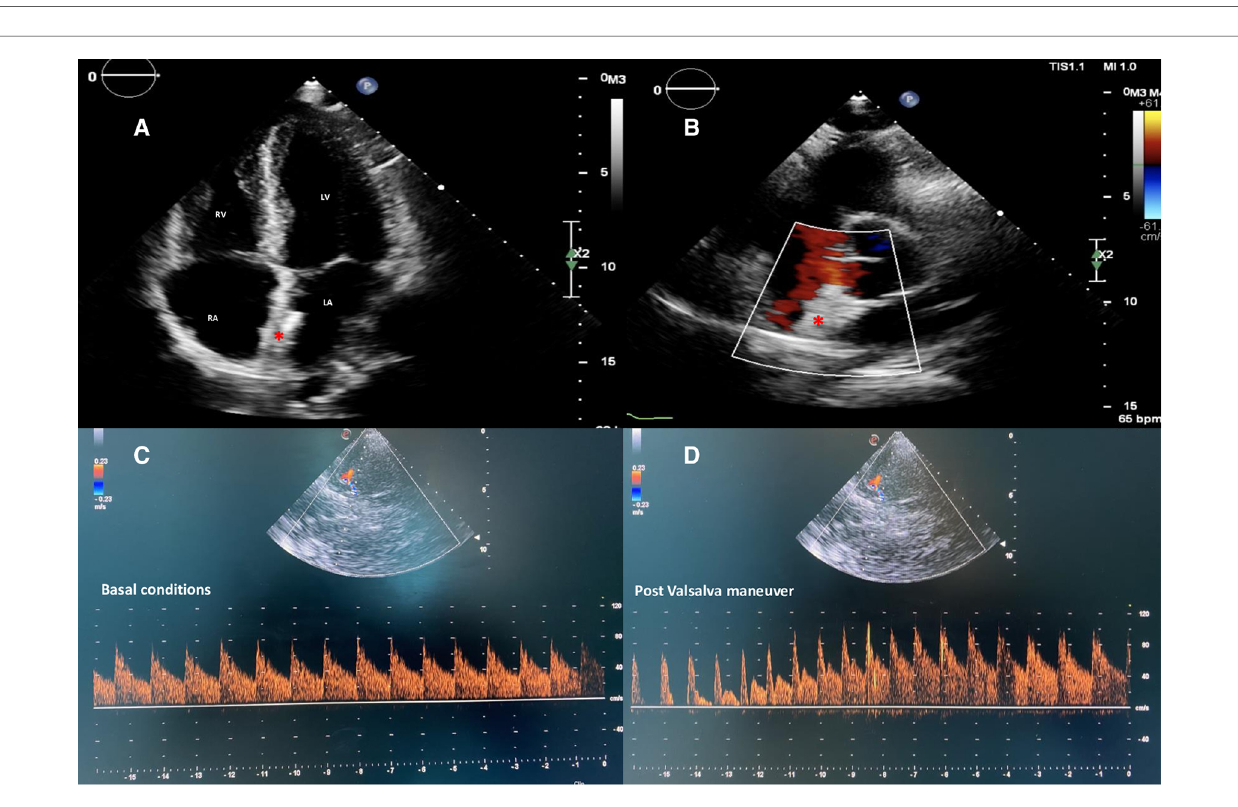
FIGURE 4 Two-dimensional TTE color Doppler in apical four-chambers ( A ) and parasternal short-axis ( B ) views showing a correct and stable position of the equally sized discs nitinol device (red asterisk) without residual shunt. cTCD con fi rming abolition of the interatrial shunt both in basal conditions ( C ) and after adequate Valsalva maneuver ( D ). TTE, transthoracic echocardiography; cTCD, contrast transcranial